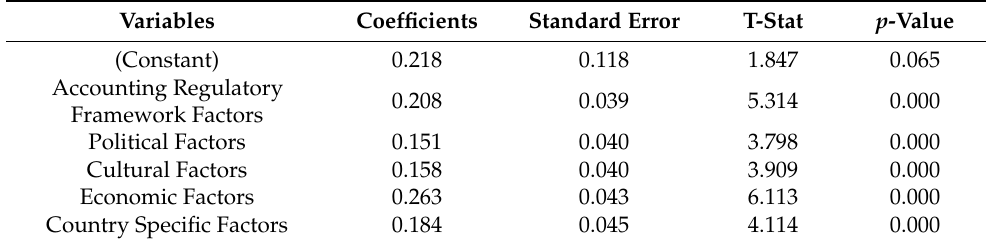
Table 6. Regression Analysis